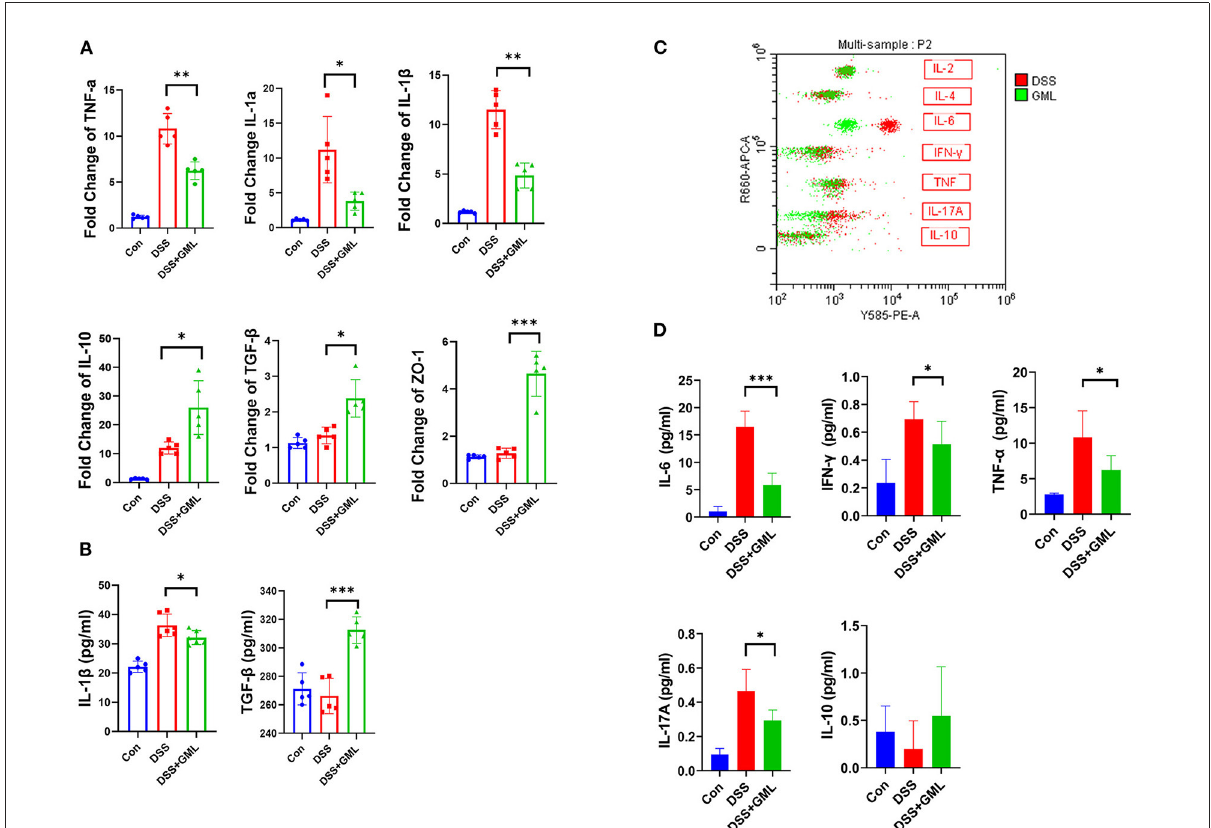
FIGURE2 GML decreased the expression of pro-inflammatory cytokines and increased the expression of anti-inflammatory cytokines in DSS-challenged mice. (A) mRNA expression levels of TNF- α , IL-1 β , IL-1 α , TGF- β , IL-10, ZO-1. (B) Concentrations of IL-1 β and TGF- β in serum by ELISA. (C) Results of cytometric bead array immunoassay analysis. (D) Quantitative analysis of inflammatory factors (IFN- γ , TNF- α , IL-6, IL-17A and IL-10) in serum. The data are expressed as the means ± SDs ( n = 5). * P < 0.05; ** P < 0.01; *** P <